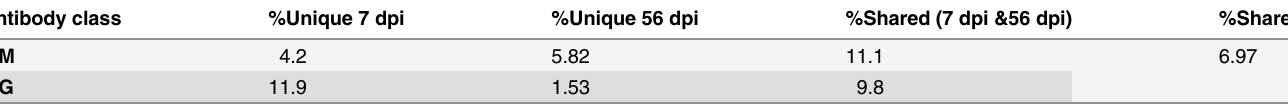
Table 5. Percentage of the immunoreactive polypeptide